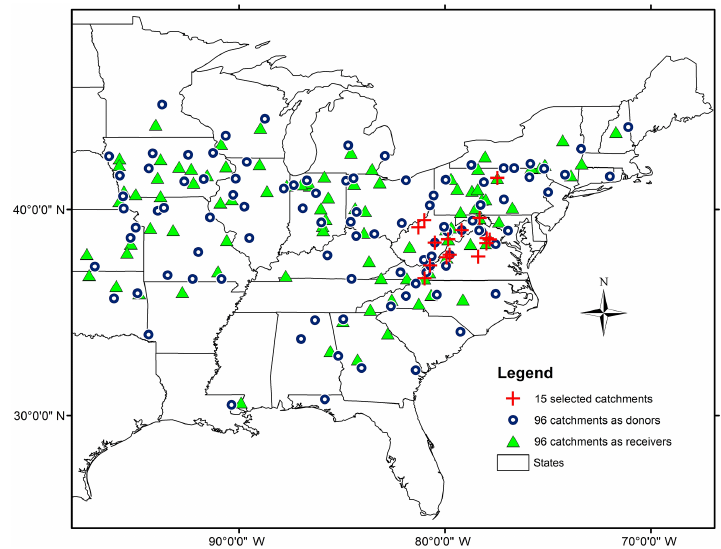
Figure 1. Location of the catchments selected for the